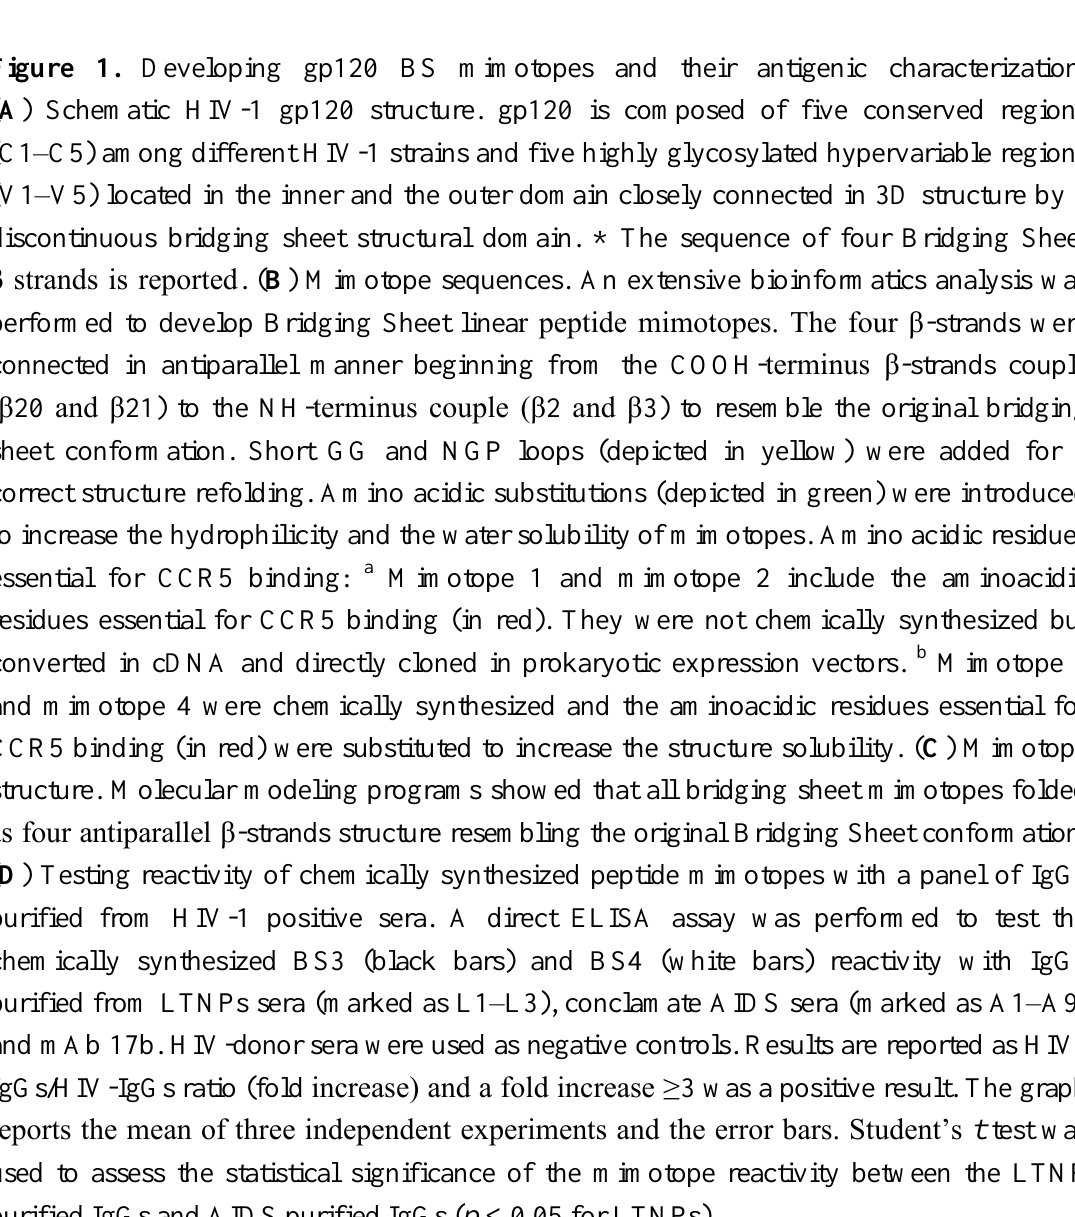
Figure 1. Developing gp120 BS mimotopes and their antigenic